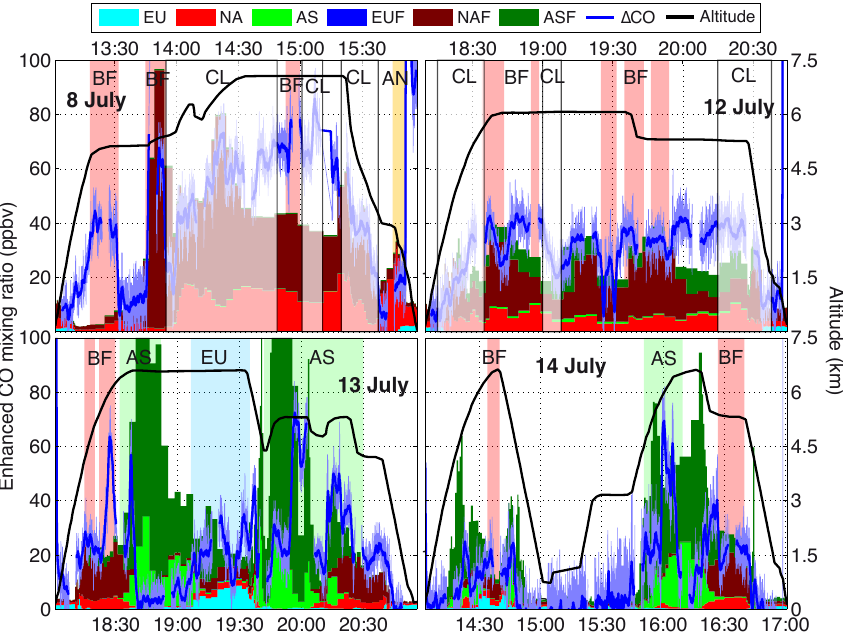
Fig. 4. Time series of ATR-42 in-situ measurements of enhanced carbon monoxide mixing ratio over background ( 1 CO), along the flight tracks (flights on 8, 12, 13 and 14 July). The anthropogenic continental source apportionments of CO enhancements over background from the FLEXPART backward simulations are shown in different colors for Europe (EU), Asia (AS) and North America (NA). Likewise fire contributions from the three continents are indicated with EUF, ASF and NAF. Air masses selected for this study are highlighted in red for Canadian boreal fires (“BF”) and yellow for anthropogenic (“AN”) air masses. Asian (“AS”, green) and European (“EU”, blue) air masses, discussed in Schmale et al. (2011), are also indicated. Cloudy periods (“CL”, in white) are indicated in white with black frame.